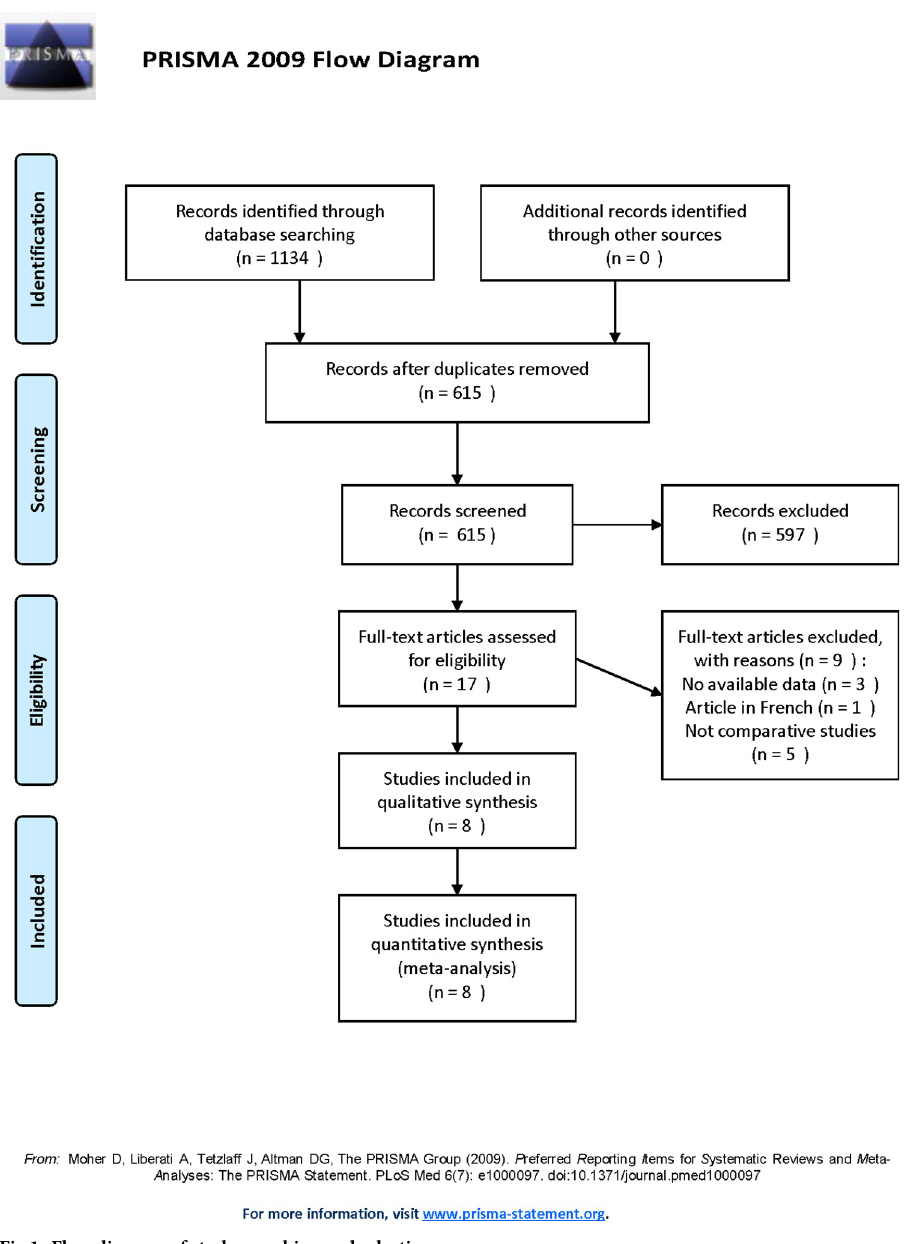
Fig 1. Flow diagram of study searching and selection